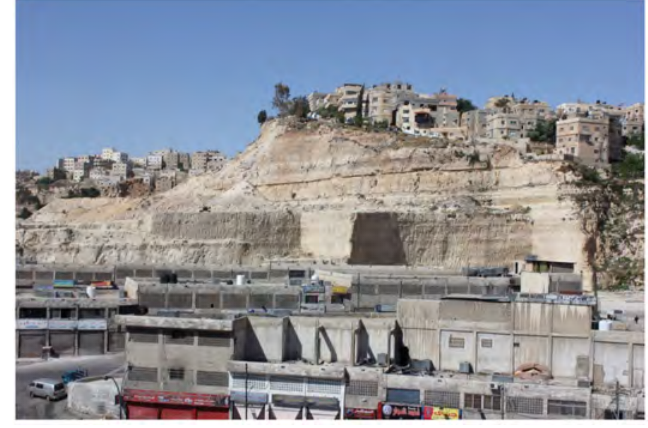
Figure 9. Quarry site within the urban setting in Amman. Source: author (2015)